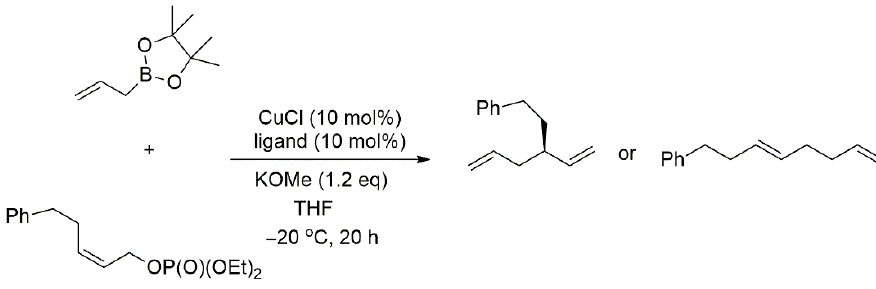
Figure 17. Bidentate NHC-OH ligand for enantioselective allylic alkylation [98].